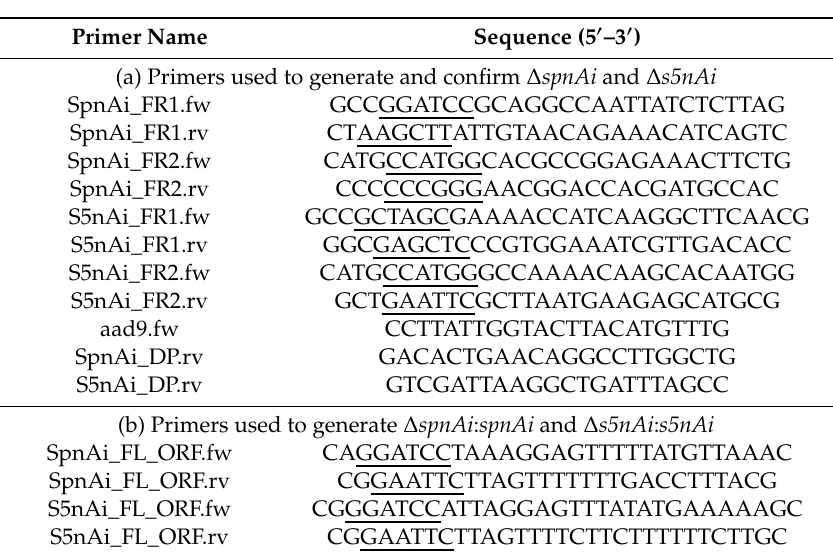
Table 1. Primers used in this study. The restriction site in each primer is